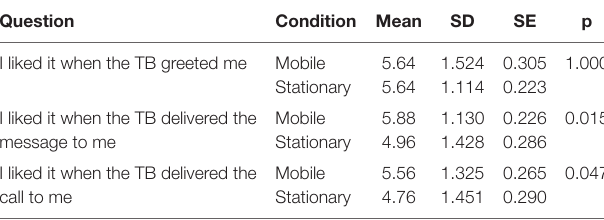
TaBle a1 | Task context: mobile vs stationary results.